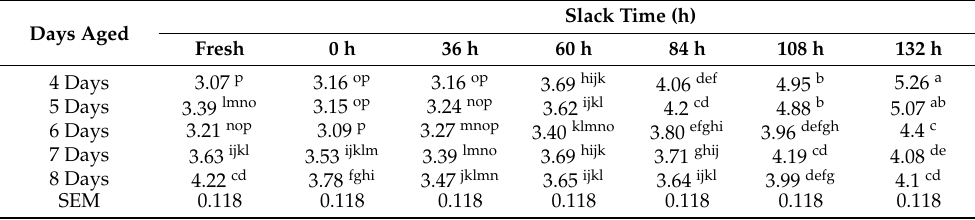
Table 3. Interactive impact (days aged 1 × slack time 2 ) of psychotropic plate count values 3 of the chicken tenderloins during simulated food service